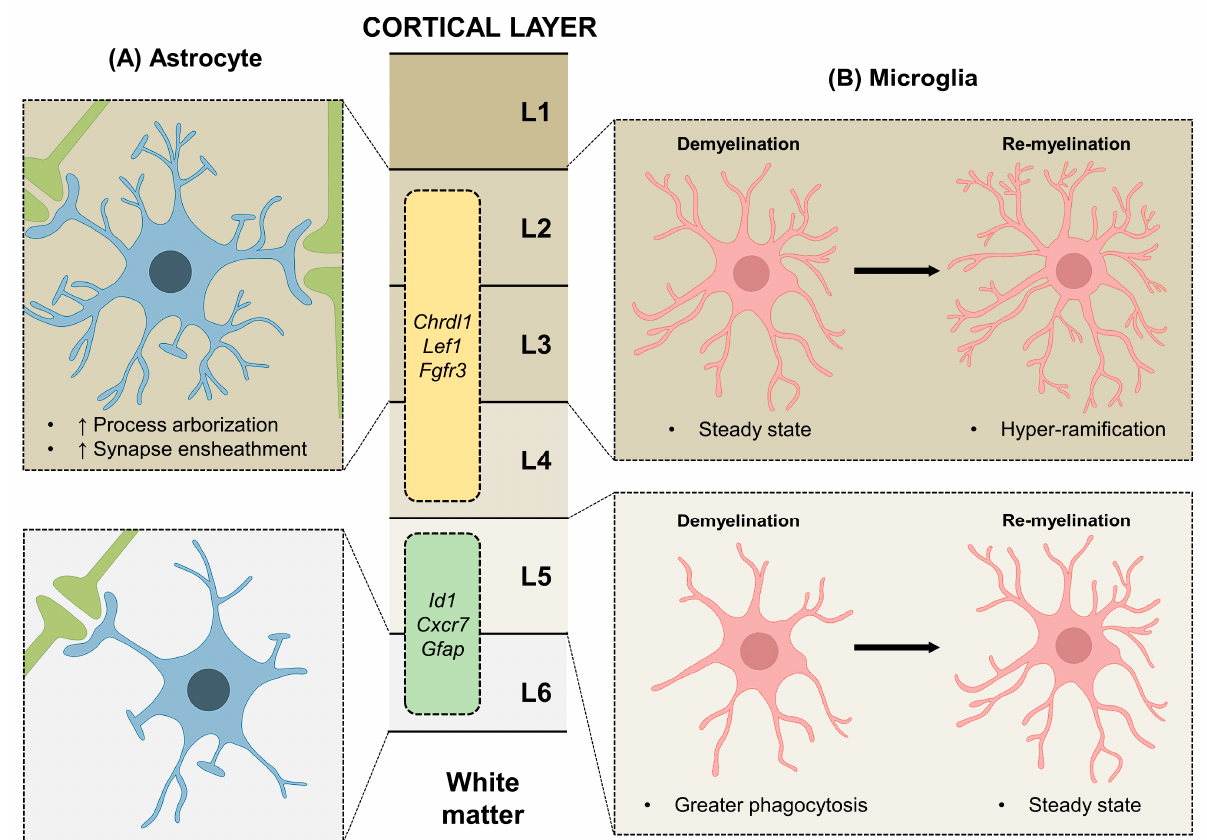
Figure 1. Intraregional heterogeneity of astrocytes and microglia in cortical layer. ( A ) Cortical layer 2/3 (L2/3) astrocytes (blue) have distinct characteristics when compared to L6 astrocytes. L2/3 astrocytes have greater process arborization and synapse ensheathment than the L6 astrocytes, leading to greater synaptic regulation. The molecular features of upper-layer astrocytes (ULAs, orange box) and deep-layer astrocytes (DLAs, green box) are shown. ( B ) Microglia (pink) in different cortical layers also show diverse responses to demyelination and remyelination. When demyelination is induced with cuprizone, a copper chelator, the microglia in L5 show increased phagocytosis, while L2/3 microglia remain at steady state. On the other hand, the L2/3 microglia display hyper- ramification under remyelination, while L5 microglia remain at steady state. Chrdl1 : chordin-like 1; Lef1 : lymphoid enhancer binding factor 1; Fgfr3 : fibroblast growth factor receptor 3; Id1 : inhibitor of differentiation-1; Cxcr7 : chemokine receptor 7; Gfap : glial fibrillary acidic